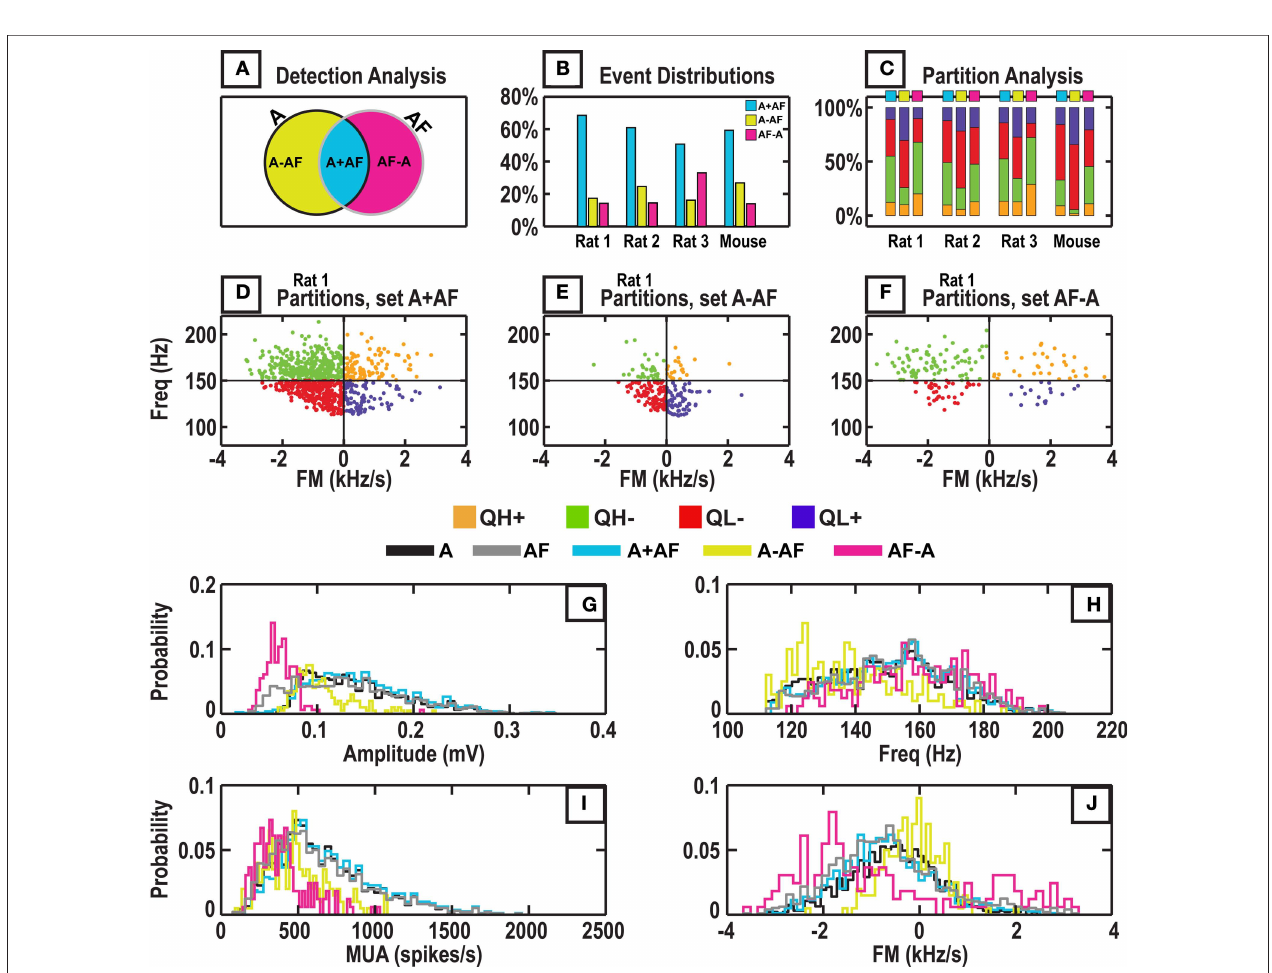
horizontal line is the detection threshold. (C) The proposed detection signal that contains amplitude and frequency information. The